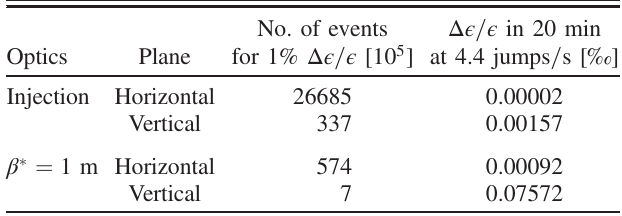
TABLE I. Number of flux jumps in the magnetic field needed to get a 1% emittance blowup and emittance growth in 20 minutes (approximate duration of an energy ramp) at a rate of 4 . 4 jumps = s rate for injection optics and β (cid:1) ¼ 1 m.